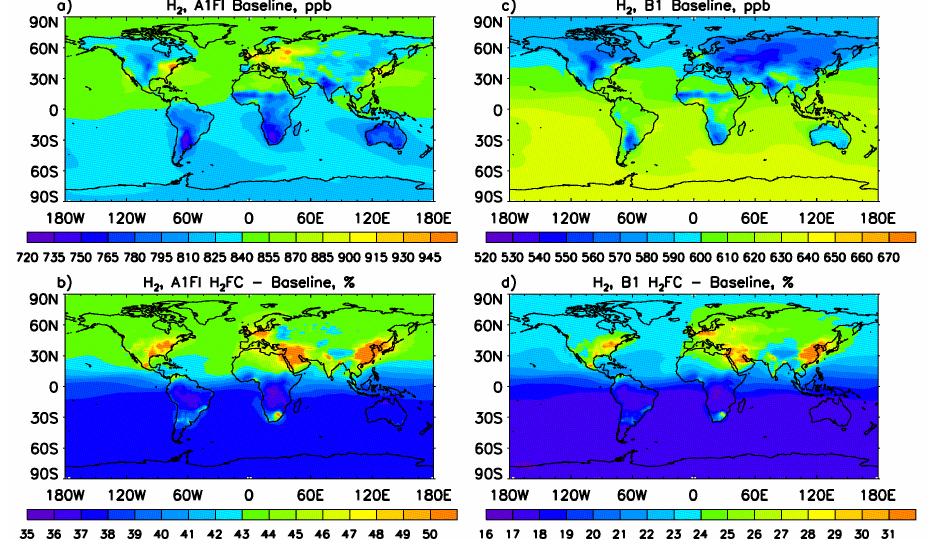
mixing ratios in the A1FI 2 2 2